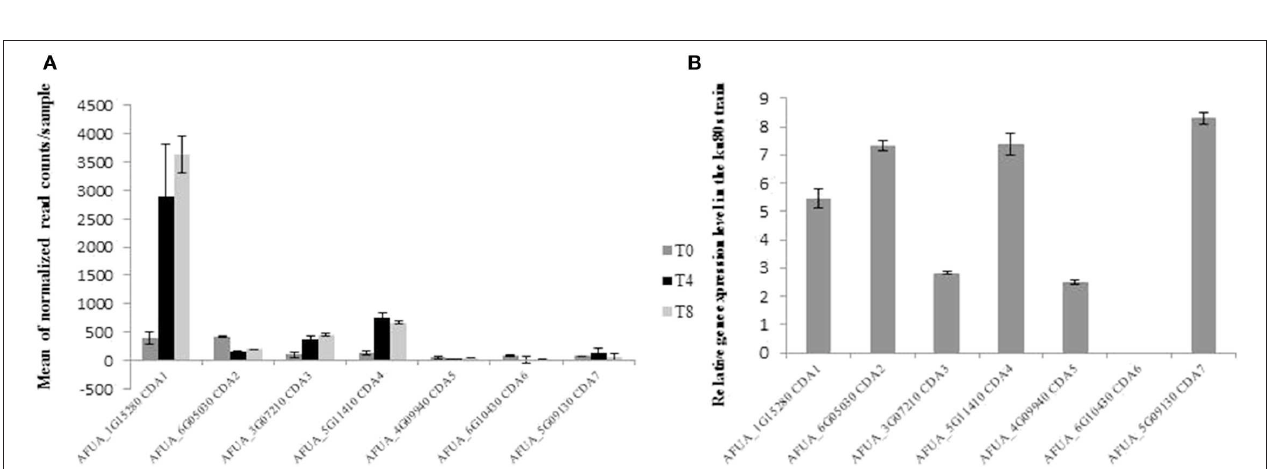
FIGURE 3 | Bioinformatic analysis of CDA genes in fungi. Conserved domains and architecture of seven putative chitin de-N-acetylase in A. fumigatus . CDA, chitin deacetylase domain; PDA, polysaccharide deacetylase domain; CBD, chitin binding domain; ADH, deshydrogenase domain (Pfam 00106).